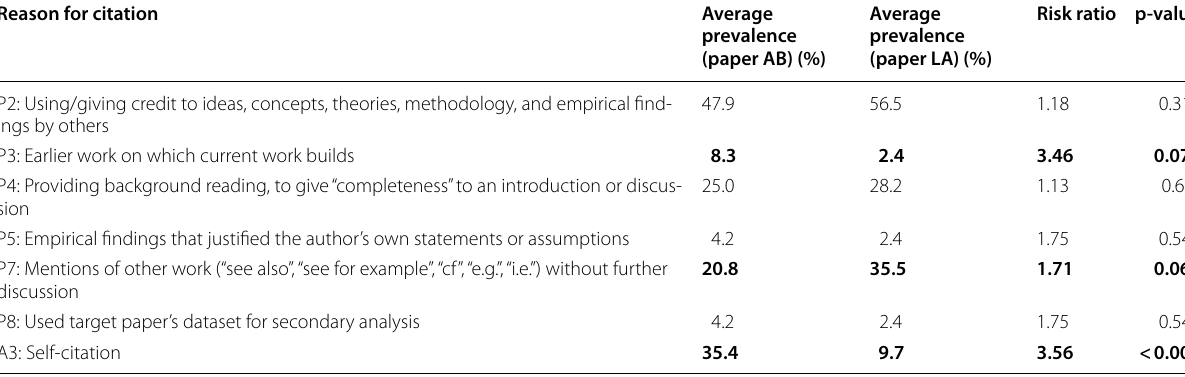
Statistically significant or marginally significant differences between the two paper types are given in boldface